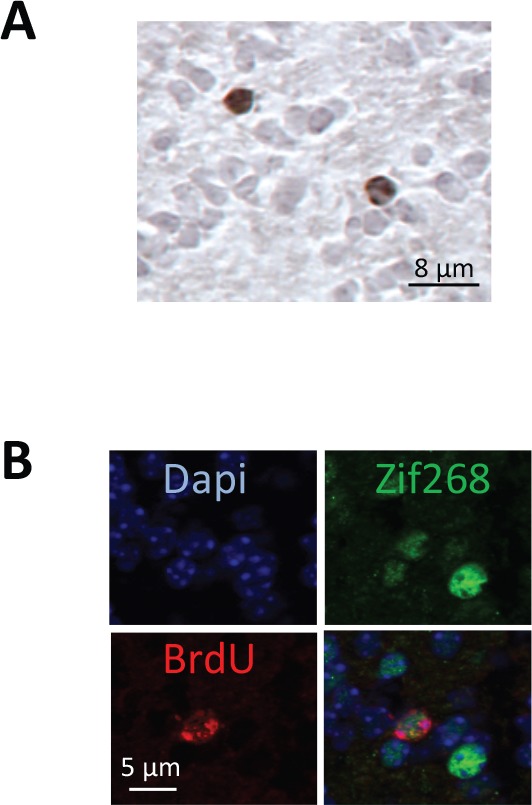
Adult-born neuron survival and responsiveness to learned odorant.(A) Adult-born cells were labeled before training using cell division marker bromodeoxyuridine (BrdU) injection and counted in the granule cell layer of the OB at the end of training (25 days post-BrdU injection). This experimental schedule allowed assessment of the impact of learning on labeled neuron survival. This image is representative of all BrdU positive cells counted. (B) Representative image of a double labeled BrdU/Zif268-positive cell.